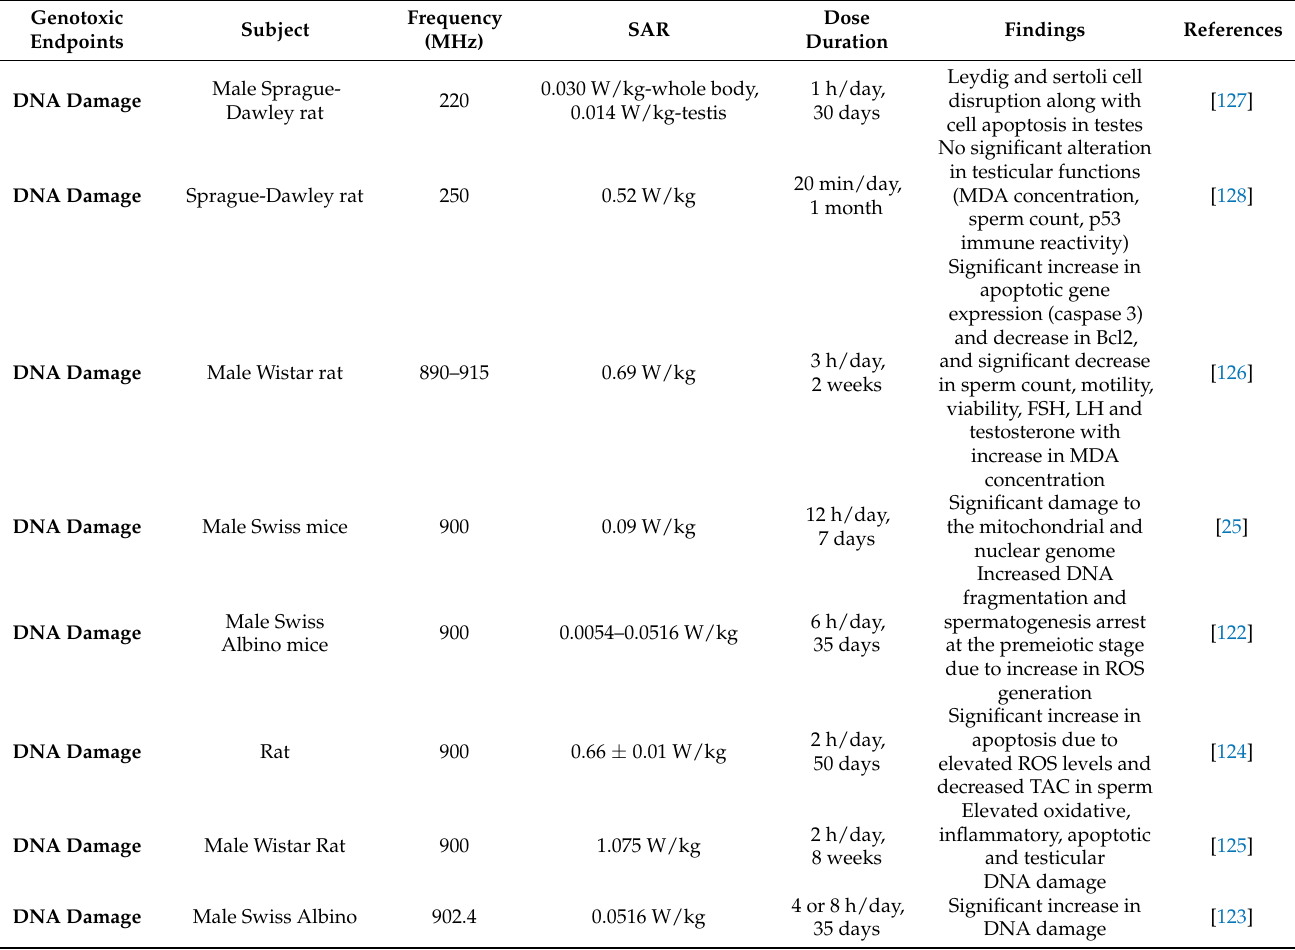
Table 2. In vivo genotoxic studies on male reproductive